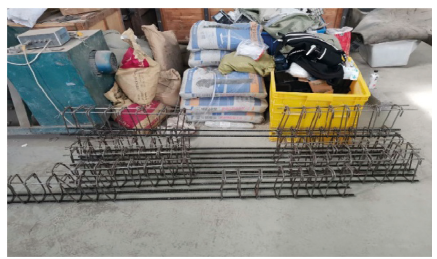
Figure 3: Casting of specimens.